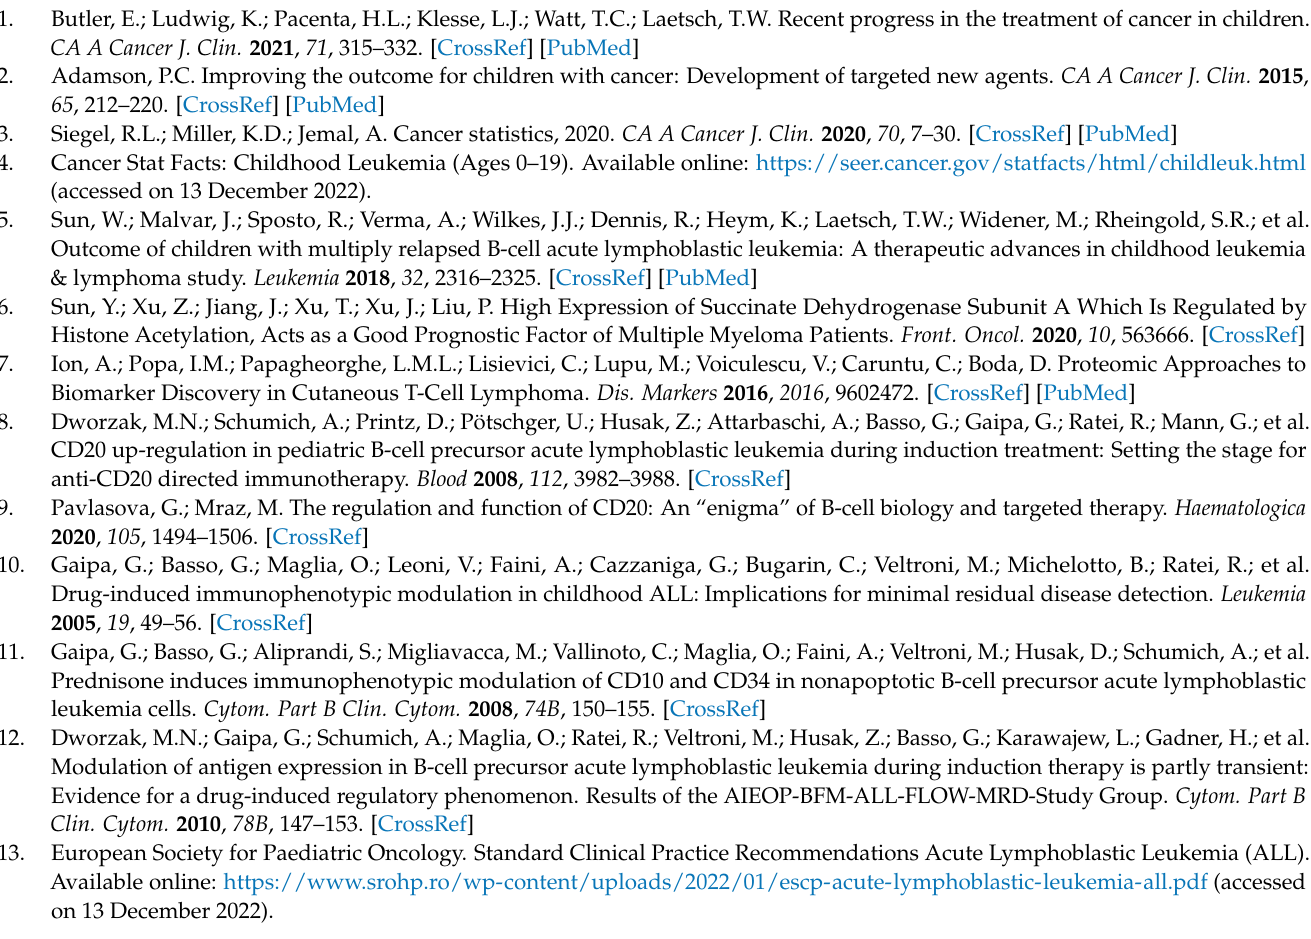
Kaplan–Meier curves representing the effect of the selected cut-off points of diagnosis CD20 MFI on OS, Figure S4: Kaplan–Meier curves representing the effect of the selected cut-off points of day 15 CD20 MFI on OS, Figure S5: Kaplan–Meier curves representing the effect of the selected cut-off points of delta CD20 MFI on